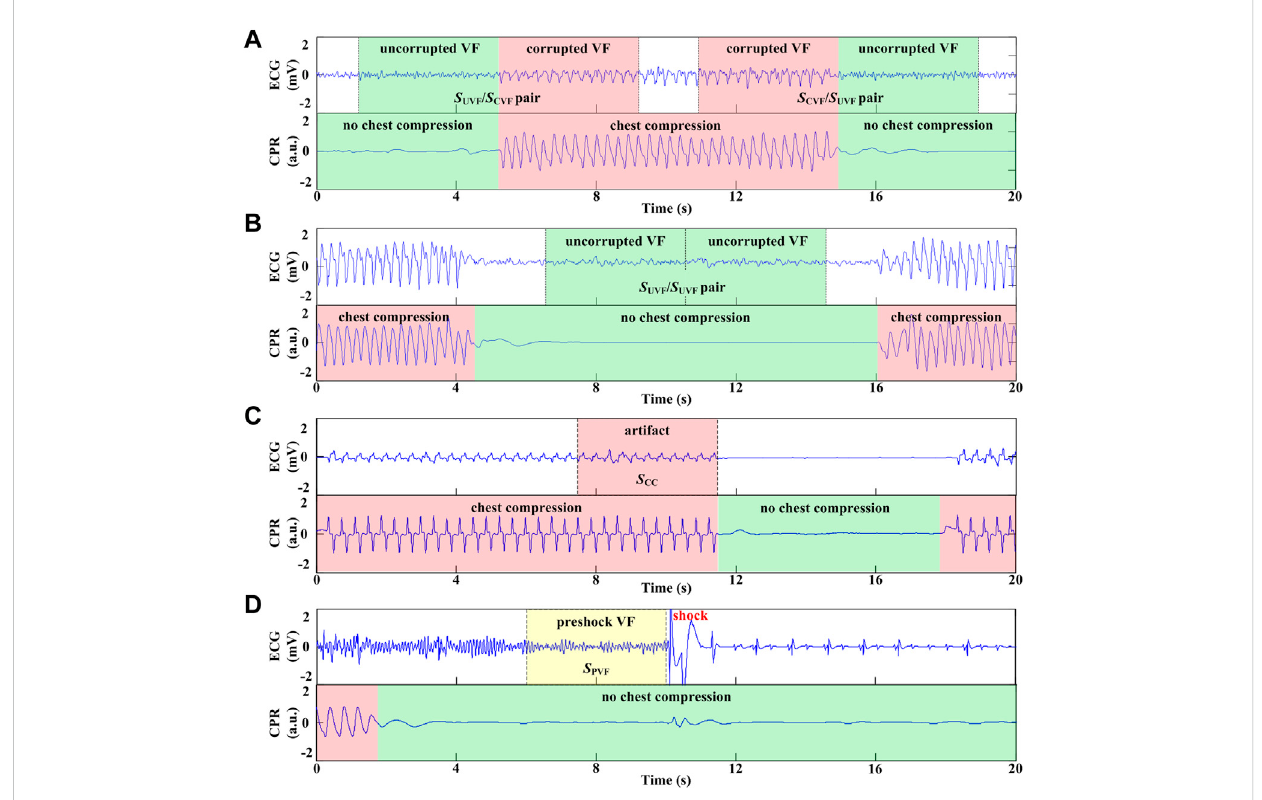
where P UVF is the power of S UVF and P CC is the power of S CC . For each S SVF , the AMSA calculated from the original S UVF based on FFT was labeled as the true value. (2) Real-life data. Similar to the derivation set, the S UVF / S CVF and S CVF / S UVF pairs from an additional 138 cases served as testing data, while AMSA calculated from the adjacent S UVF based on FFT was labeled as true value. (3) Preshock data. The preshock VF signal S PVF with annotated cardiac rhythm after each de fi brillation shock constituted the testing set, and the AMSA calculated by the FFT method was labeled its true value. The FFT-based AMSA is calculated as the sum of the products of individual frequencies and their amplitudes converted from the time to the frequency domain by FFT using a Tukey window (Li et al., 2013): S f (cid:6) (cid:7) f d f (2 ) AMSA FFT (cid:2) (cid:5) 48 2 where S ( f ) and f are the spectrum and frequency of a signal s ( n ). The lower and upper limits of f for integral summation are 2 Hz and 48 Hz, respectively.